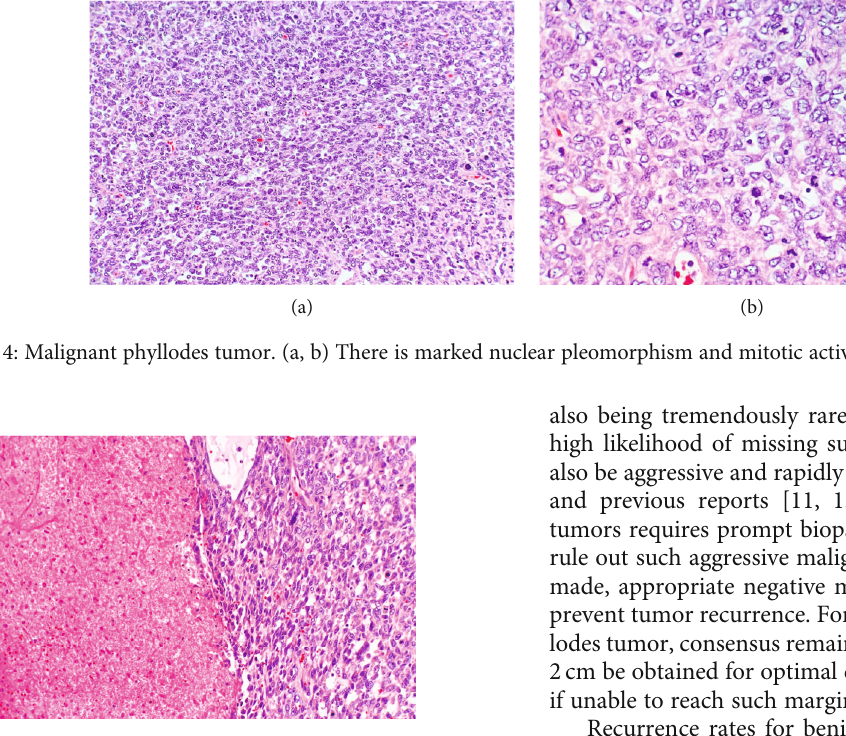
Figure 5: Malignant phyllodes tumor. An area of tumor cell necrosis (left) (H&E, ×